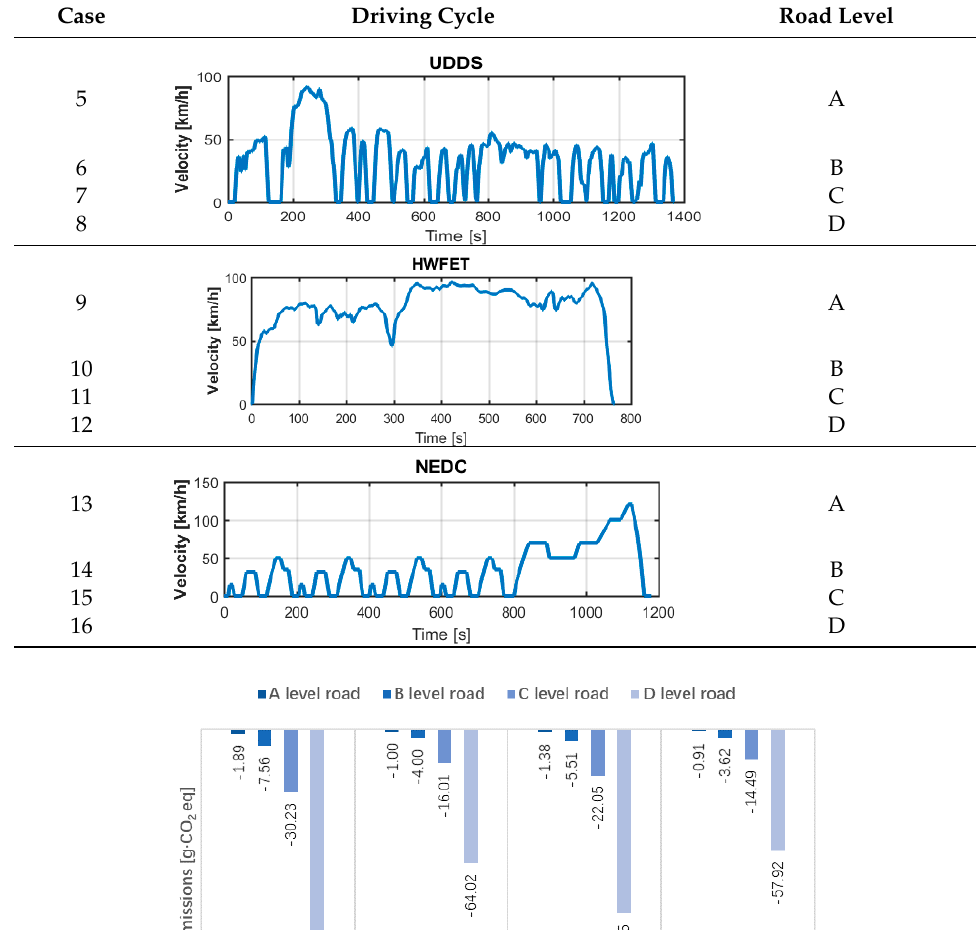
Figure 13. WTW GHG emission reduction from regenerative suspension under different country contexts.